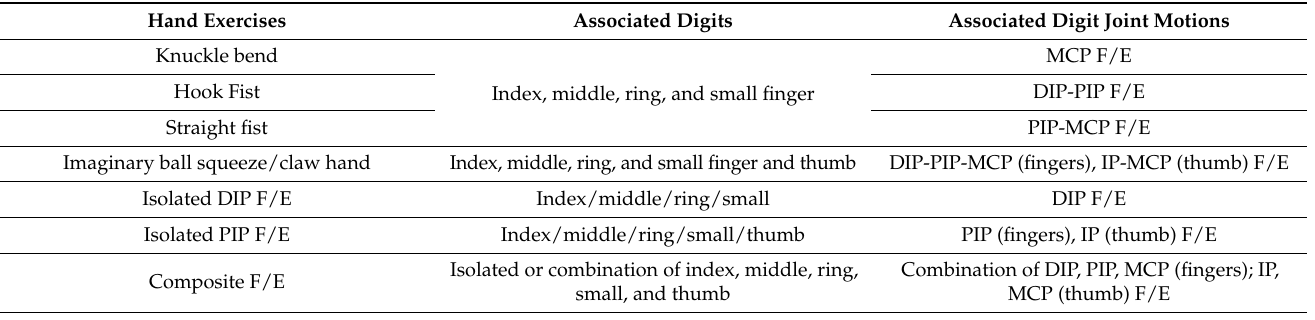
Table 1. Various hand exercises and associated digits and digit joint